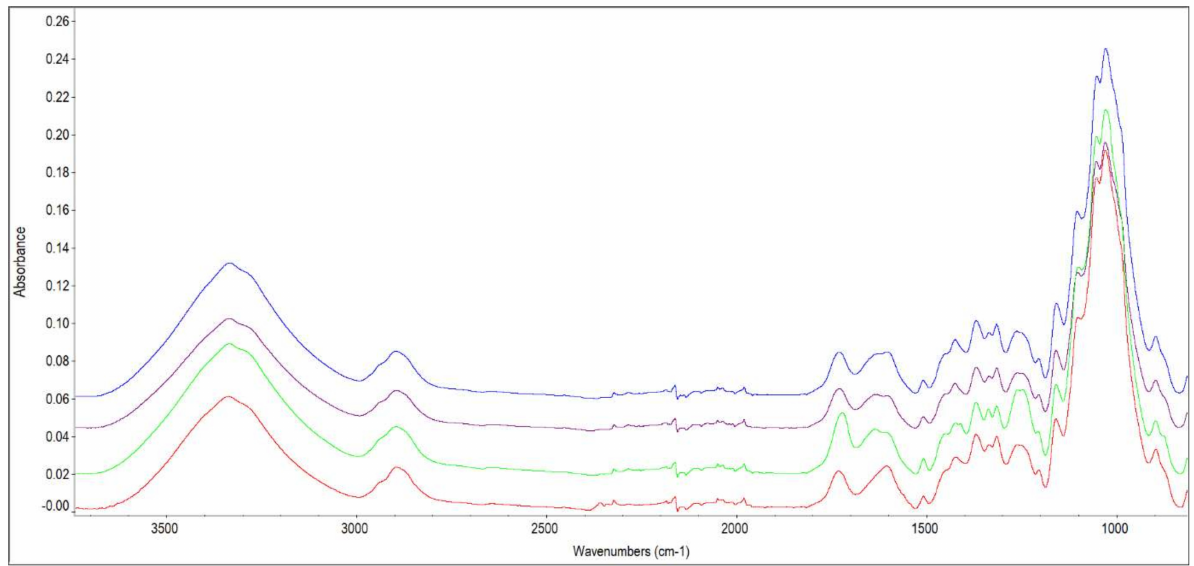
Figure 10. FTIR spectrum of holocellulose isolated from wood before and after 2, 4 and 6 months of storage (Note: blue line-December 0, magenta line-February, green line-April, red